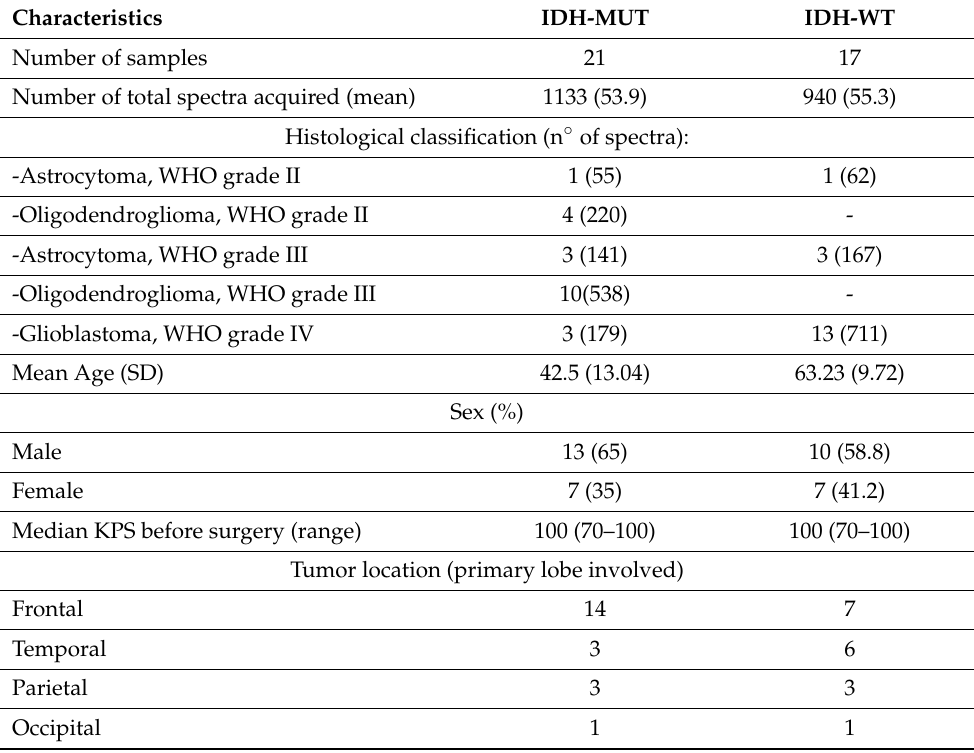
Table 1. Demographic, clinical and pathological characteristics of the study